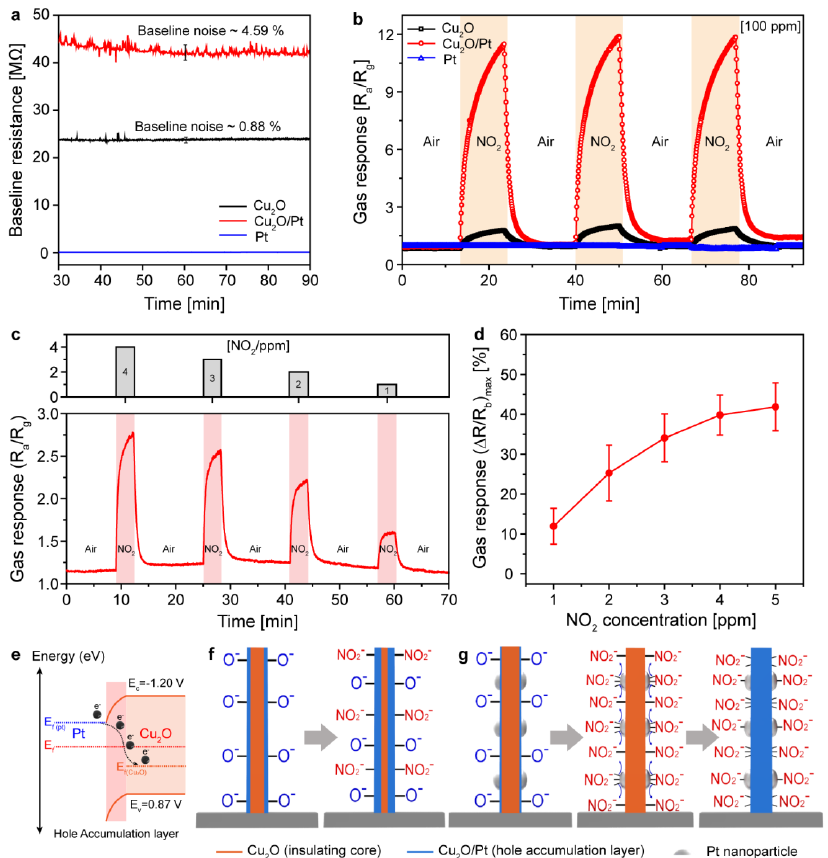
Figure 4. Device characteristics and gas sensing performance of the Cu 2 O, Cu 2 O/Pt, and Pt nanopattern sensors. ( a ) Baseline resistance and noise of the Cu 2 O, Cu 2 O/Pt, and Pt